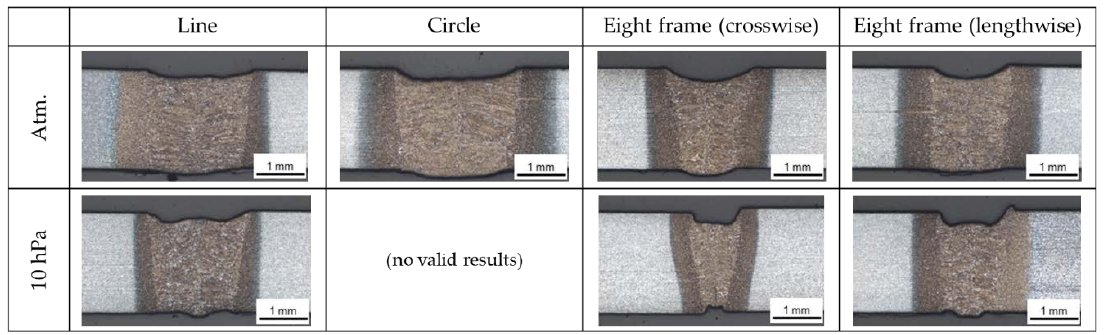
Figure 9. Macrographs of specimens prepared with a 0.2 mm gap, welded using different oscillation patterns at atmospheric pressure and 10 hPa.